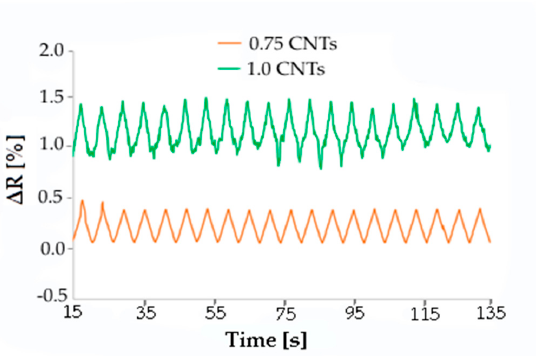
Figure 9. Displacement and resistance variation recorded during cycling of PC-ABS composite with 0.5 wt.% CNTs.